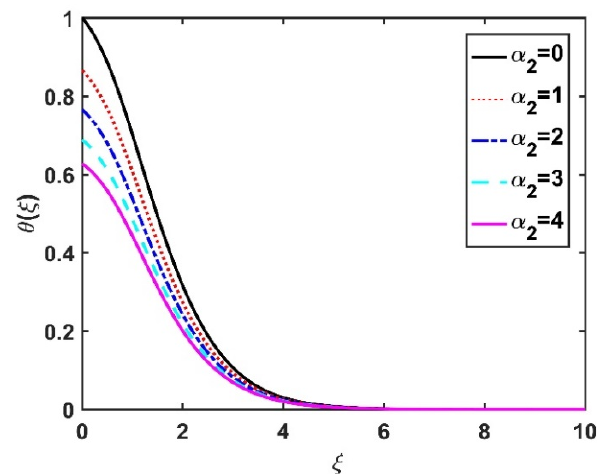
Figure 15. Impact of α 2 on θ ( ξ ) . 4.3. Nanoparticle Concentration Profile ( 𝜙(cid:4666)𝜉(cid:4667) ) The effects of the Hall current and magnetic field on 𝜙(cid:4666)𝜉(cid:4667) were contradictory, as shown in Figures 16 and 17. That is, 𝜙(cid:4666)𝜉(cid:4667) rose at the 𝑀 values decreased and the values of 𝑚 increased . The increase in the Brownian number reduced 𝜙(cid:4666)𝜉(cid:4667) , as shown in Figure 18. The greater the strength of Brownian motion, the lower the concentration gradient of